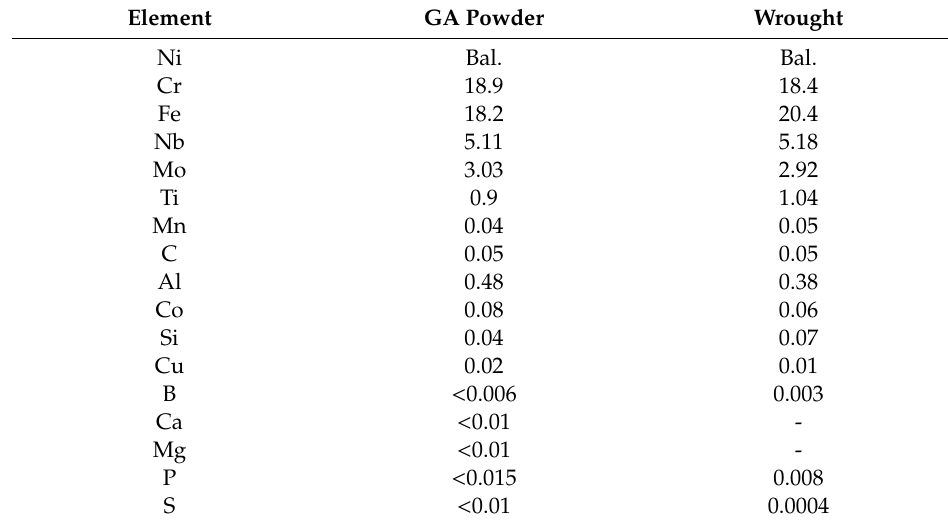
Table 1. Chemical composition of the gas-atomized (GA) Alloy 718 powder and wrought Alloy 718. (wt. %).